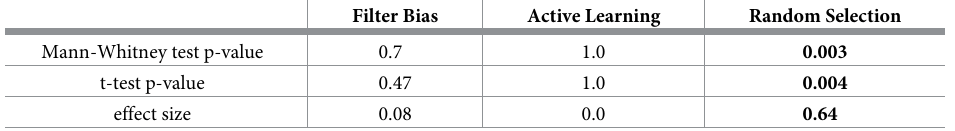
Table 11. Results of the Mann-Whitney U test and the t-test comparing boundary shift for the three forms of iter- ated algorithmic bias with class-dependent human action probability ratio 1:1 and 10:1. The effect size is calculated as ( Boundary | ratio = 1: 1 − Boundary | ratio = 10: 1 )/ standard . dev at time t = 200. Both Filter bias and active learning bias show no significant difference between the two ratios. On the other hand, random selection decreases the class-1 blind spot